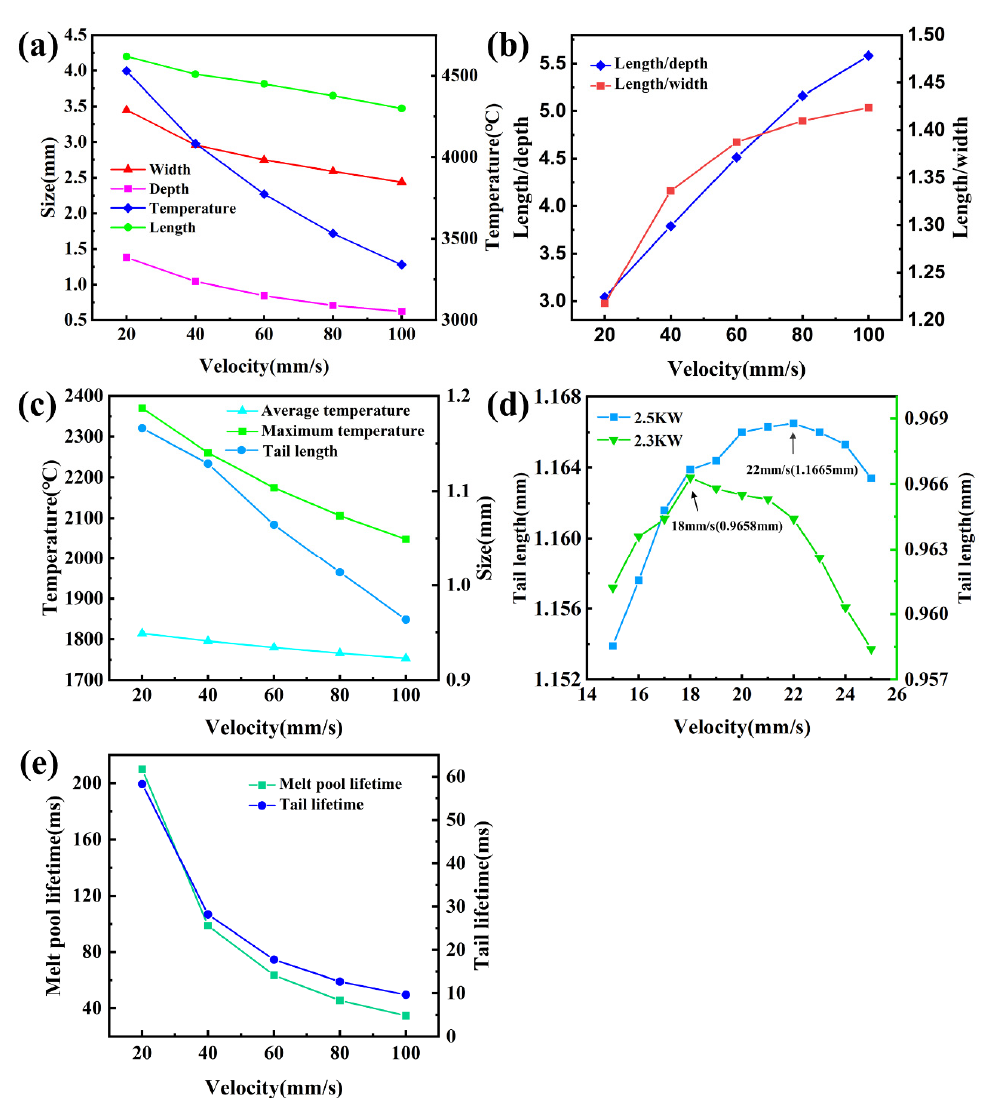
Figure 4. When the scanning velocity is in the range of 20–100 mm/s, ( a ) molten pool morphology; ( b ) characteristics of the molten pool; ( c ) tail morphology; ( d ) relationship between the tail and low scanning velocity; ( e ) the lifetime of the molten